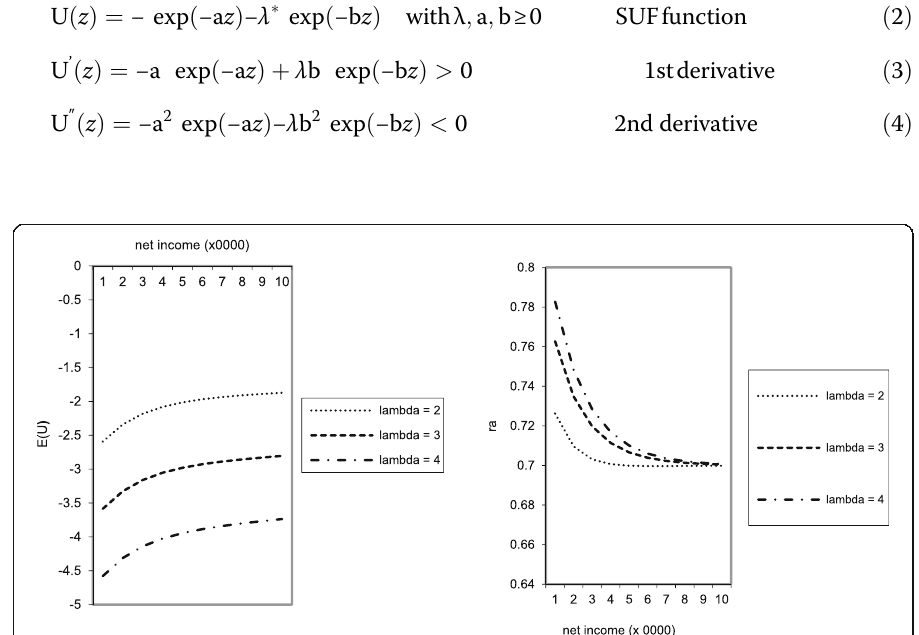
Fig. 2 Sumex utility (left) and coefficient of risk